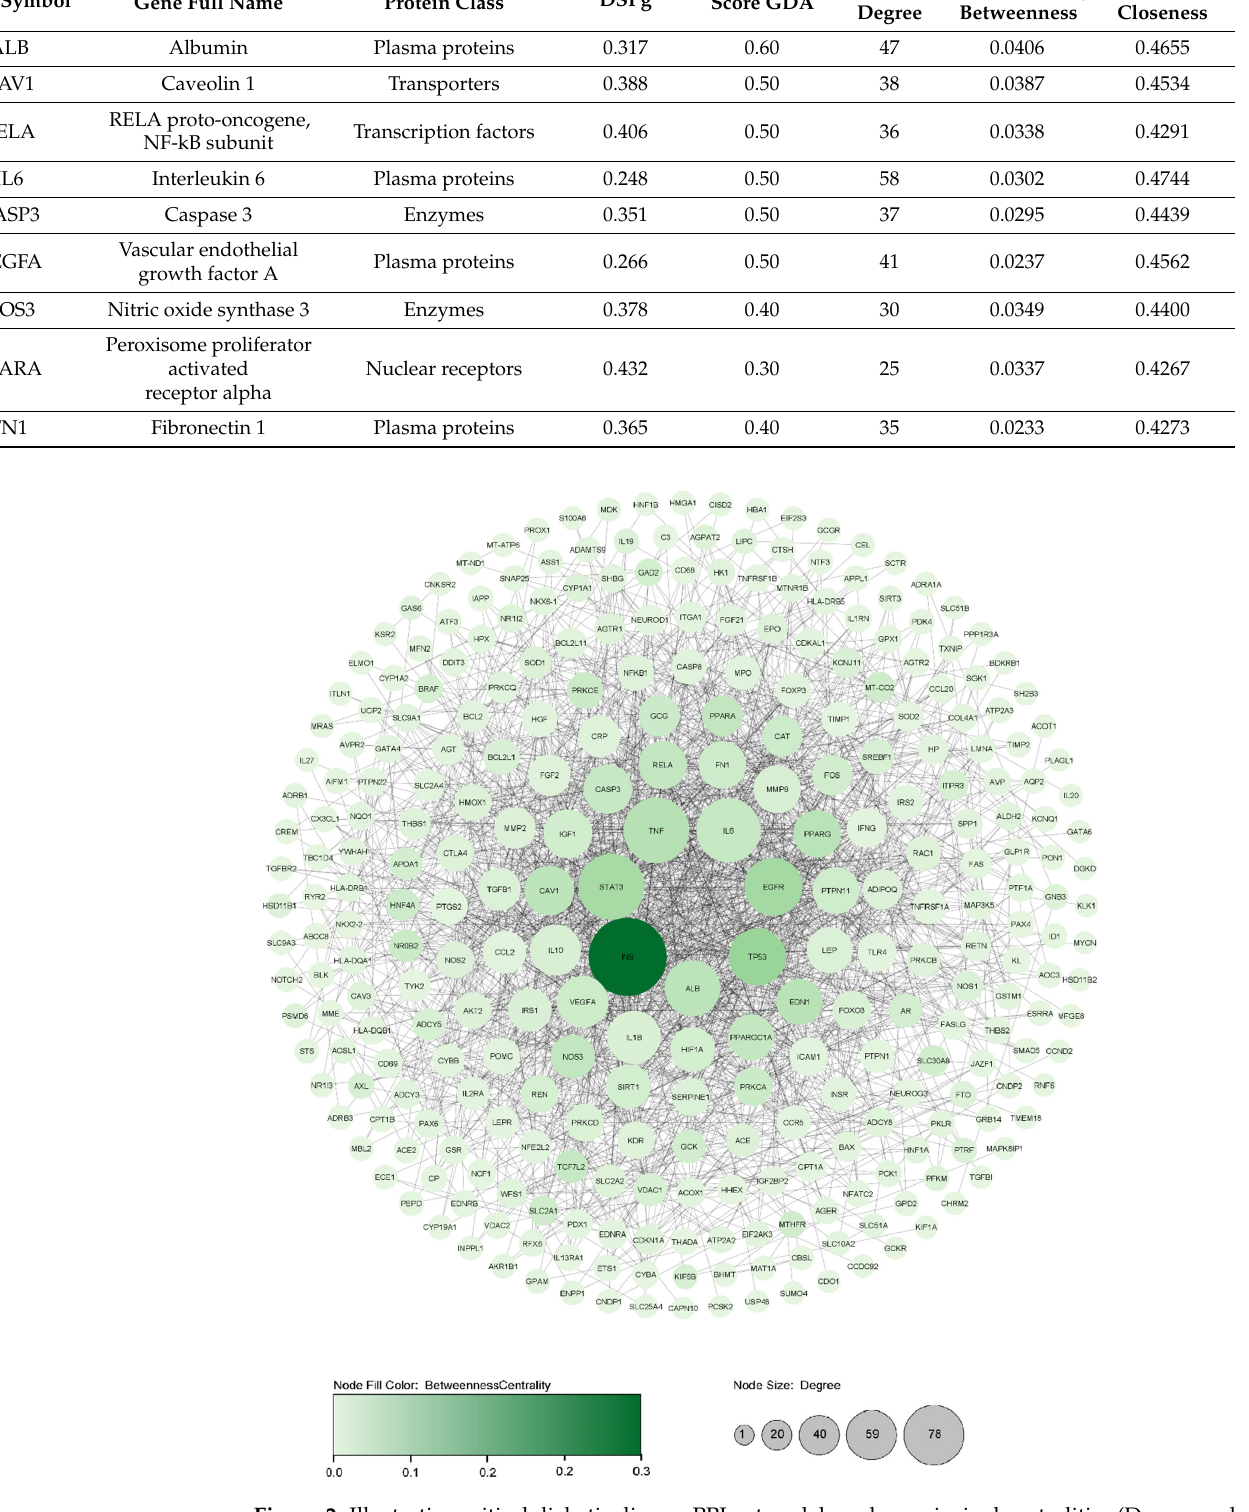
Figure 2. Illustrating critical diabetic disease PPI network based on principal centralities (Degree and Betweenness) using Cytoscape software. The entire PPI network was identified with 298 nodes and 1651 edges. The larger the node size indicates, the higher the Degree, and the higher intensity in node color indicates higher Betweenness in the PPI network.